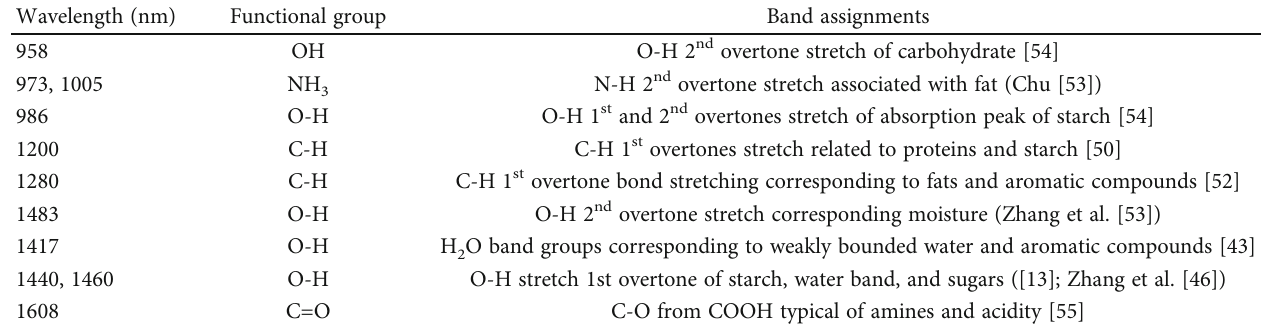
Table 2: NIR wavelength band assignments.